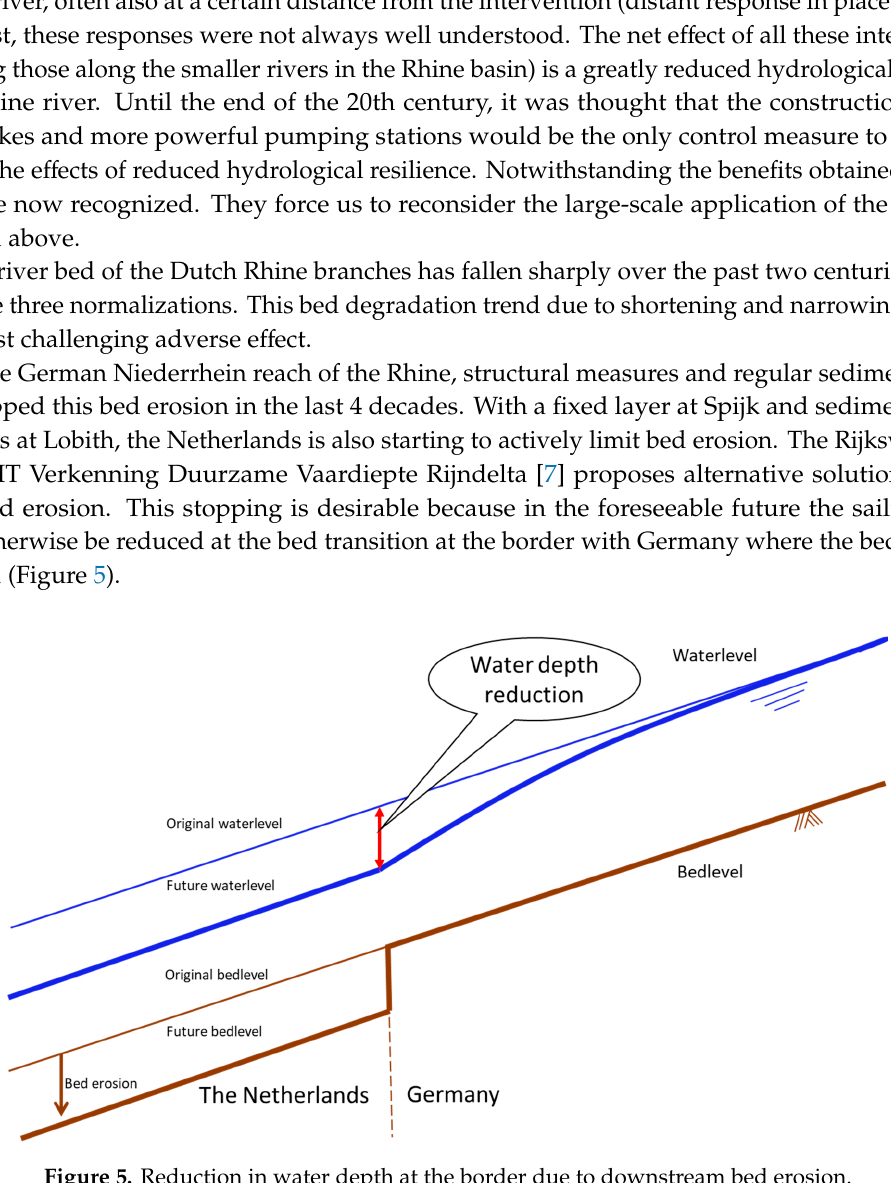
Table 1. Important intervention – response relationships caused by river training interventions.